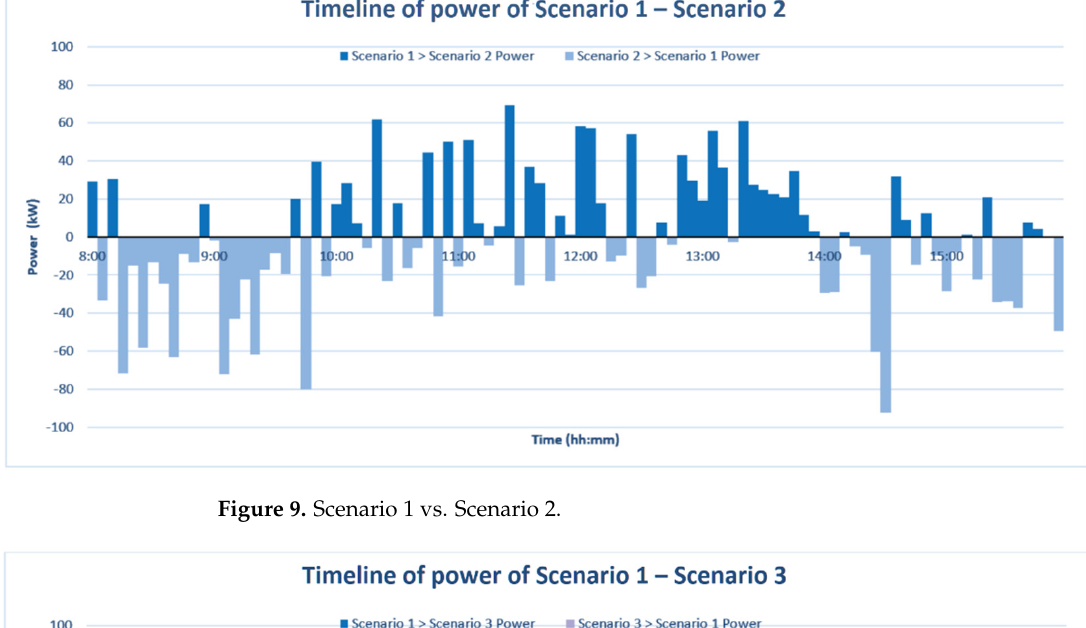
Figure 9. Scenario 1 vs. Scenario 2.